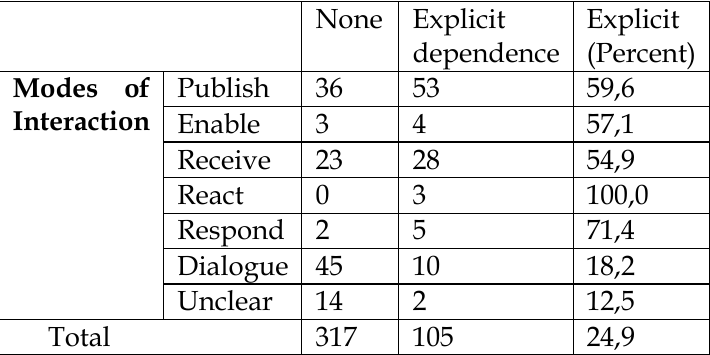
Table 5: Technology Dependency by Mode of Interaction